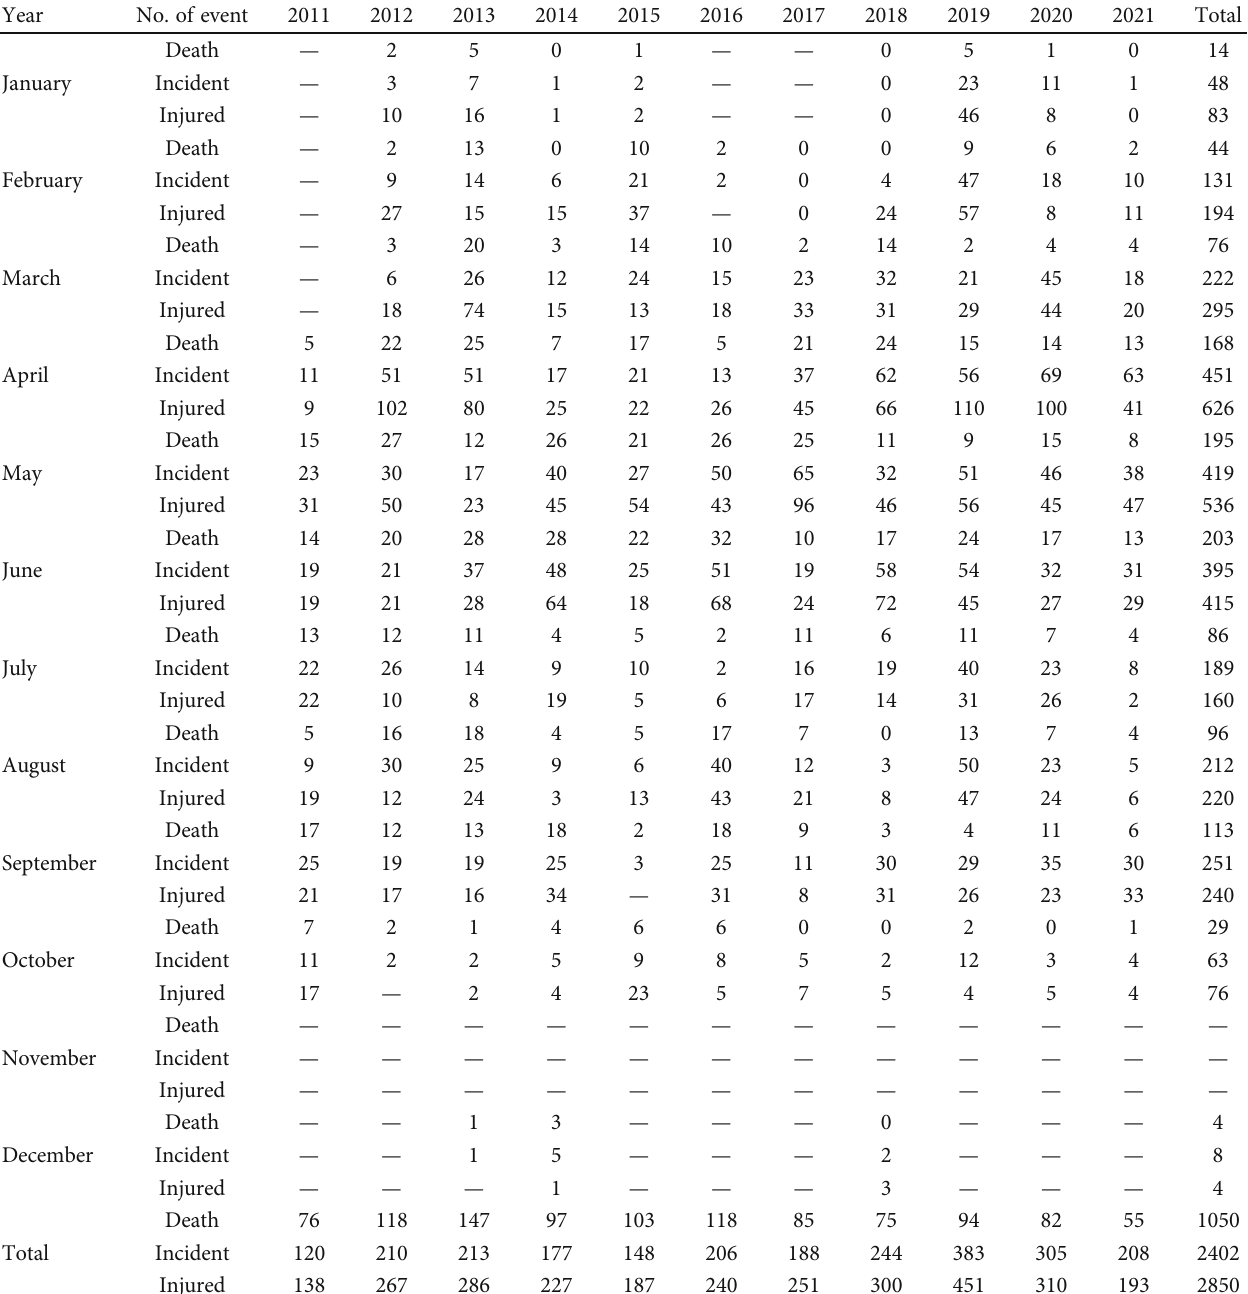
Table 3: Monthly lightning in the Himalayan region within the period of January 2011 to December